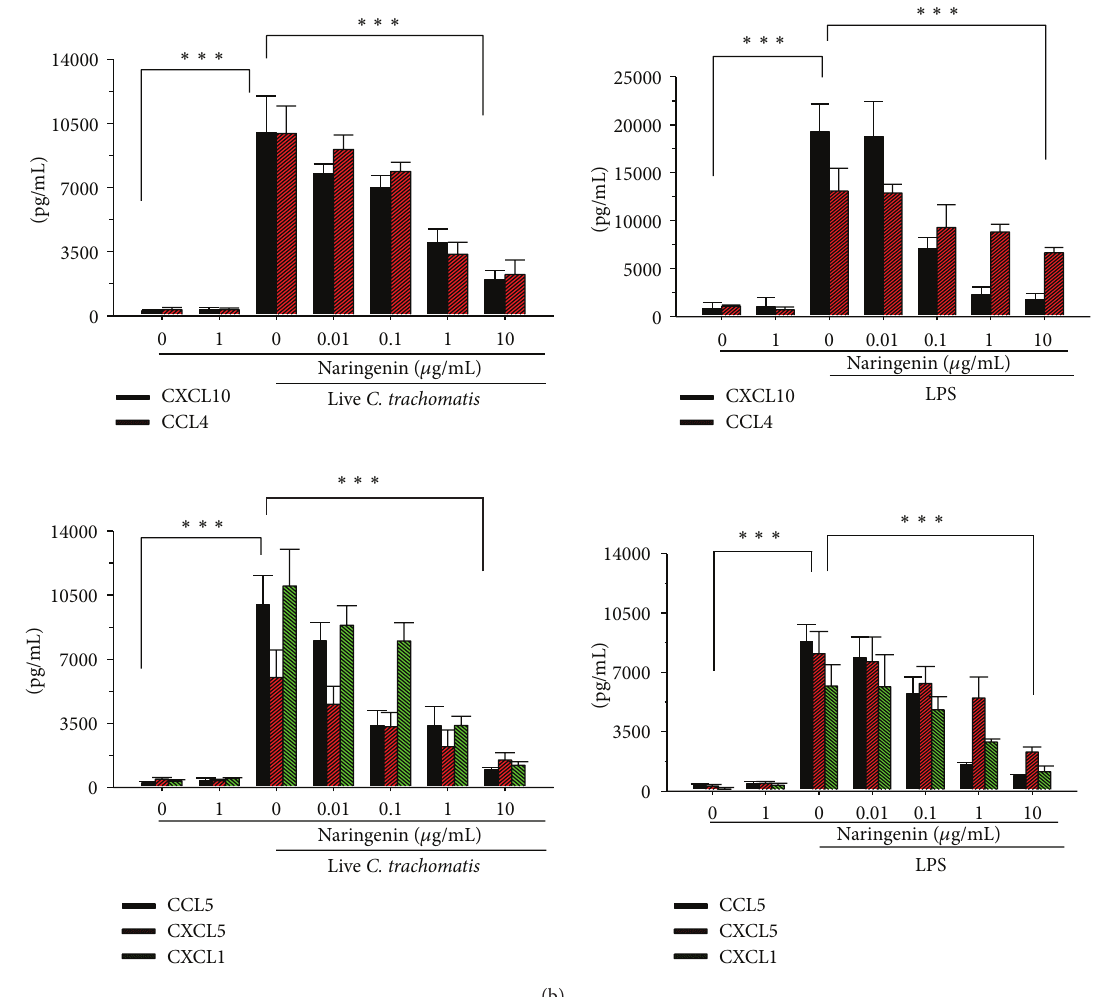
Figure 1: Naringenin downregulates inflammatory mediators in C. trachomatis infected mouse J774 macrophages. Macrophages (10 6